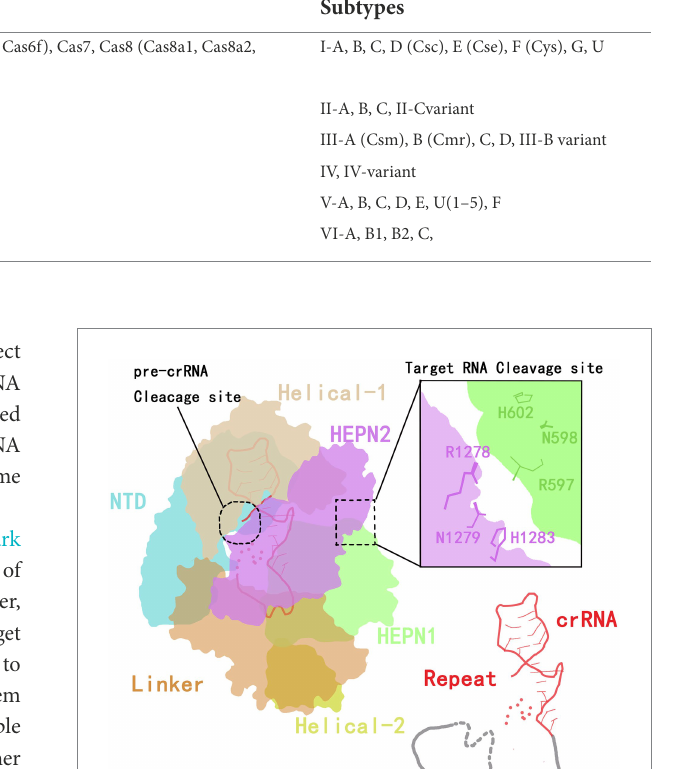
TABLE 1 The diversity and characteristics of the CRISPR-Cas system.